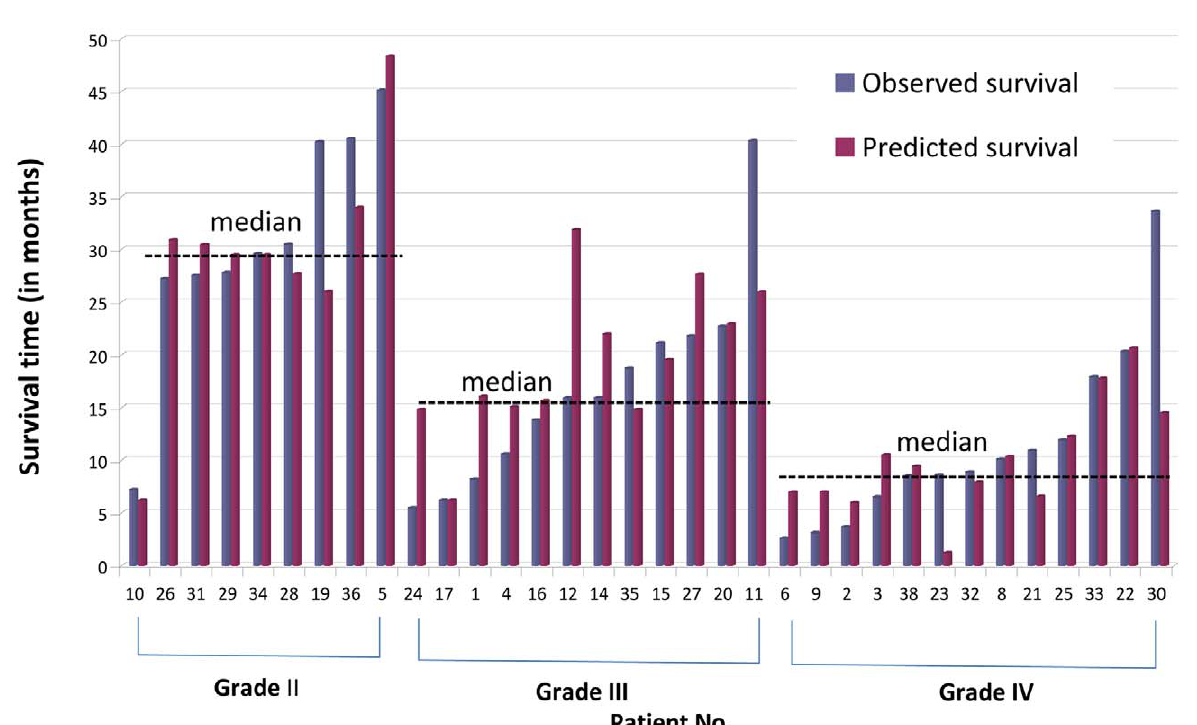
Figure 1. Observed versus predicted survival times using the four gene model. doi:10.1371/journal.pone.0025631.g001 PLoS ONE |